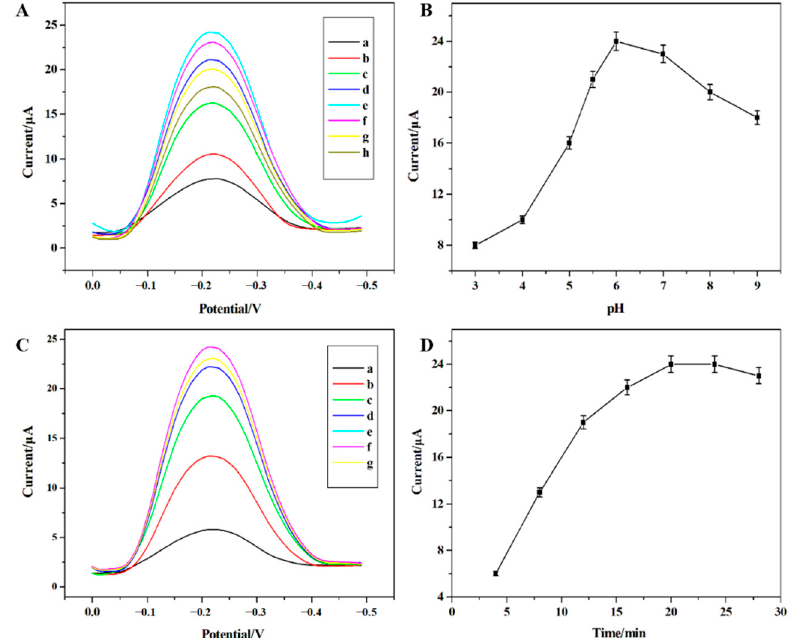
Figure 5. The voltammograms of the MIIP/Fe 3 O 4 @SiO 2 /MCPE electrode when detecting of UO 22+ ( A , B ) the effect of pH (a: pH = 3, b: pH = 4, c: pH = 5, d: pH = 5.5, e: pH = 6, f: pH = 7, g: pH = 8, h: pH=9); ( C , D ) the effect of enrichment time (a: 4 min, b: 8 min, c: 12 min, d:16 min, e: 20 min, f: 24 min, g: 28 min).